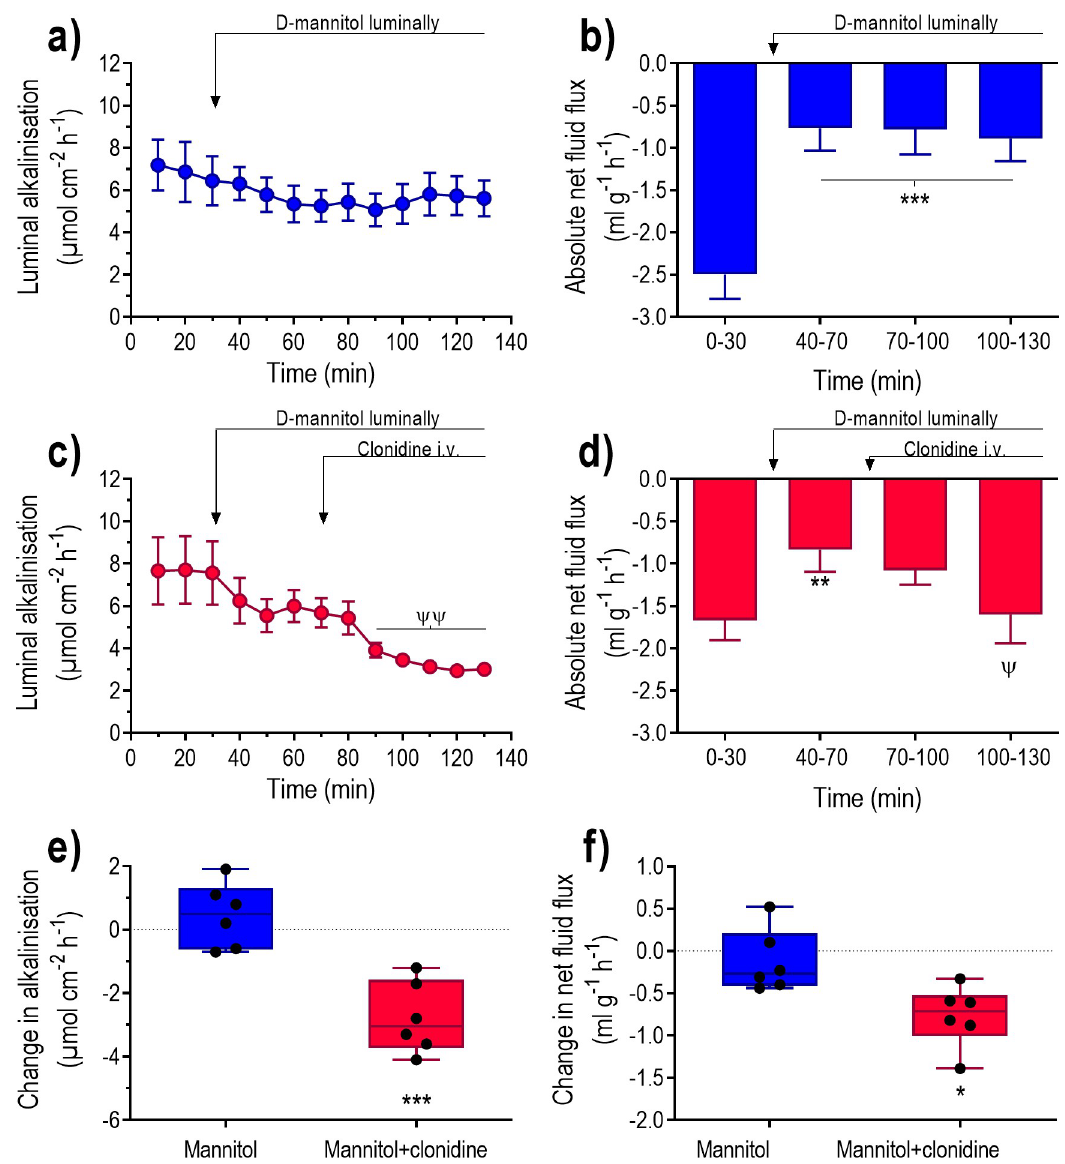
Fig 7. The effects of clonidine on fluid flux and luminal alkalinisation in rat duodenum perfused with a NaCl-free solution. Duodenum was perfused with isotonic saline for 30 min and then with an isotonic D-mannitol solution for 100 min (Fig 1). Effects on luminal alkalinisation (a and c) and transepithelial net fluid flux (b and d) were determined in the absence and presence of i.v. infusion of clonidine at a dose of 10 μ g kg -1 h -1 . Net changes in (e) luminal alkalinisation and (f) transepithelial net fluid flux between 110–130 min and 50–70 min (D-mannitol plus clonidine vs. D-mannitol alone). Values are means ± SEM or box plots with all individual points. �� P < 0.01 and ��� P < 0.001 compared with basal values. ψ P < 0.05, ψψ P < 0.01 compared with values at 50–70 min. Fig (e) and (f); � P < 0.05 and ��� P < 0.001 compared with values in animals treated with D-mannitol